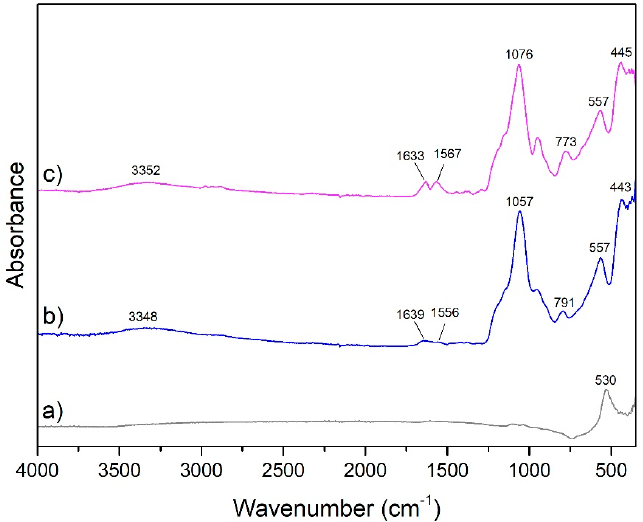
Figure 3. FTIR-ATR spectra of the nanoparticles: (a) Fe 3 O 4 ; (b) Fe 3 O 4 @SiO 2 /SiTMC and (c) FTIR-ATR spectra of the nanoparticles: (a) Fe 3 O 4 ; (b) Fe 3 O 4 @SiO 2 / SiTMC and Fe 3 O 4 @SiO 2 /SiCHIT. (c) Fe 3 O 4 @SiO 2 /